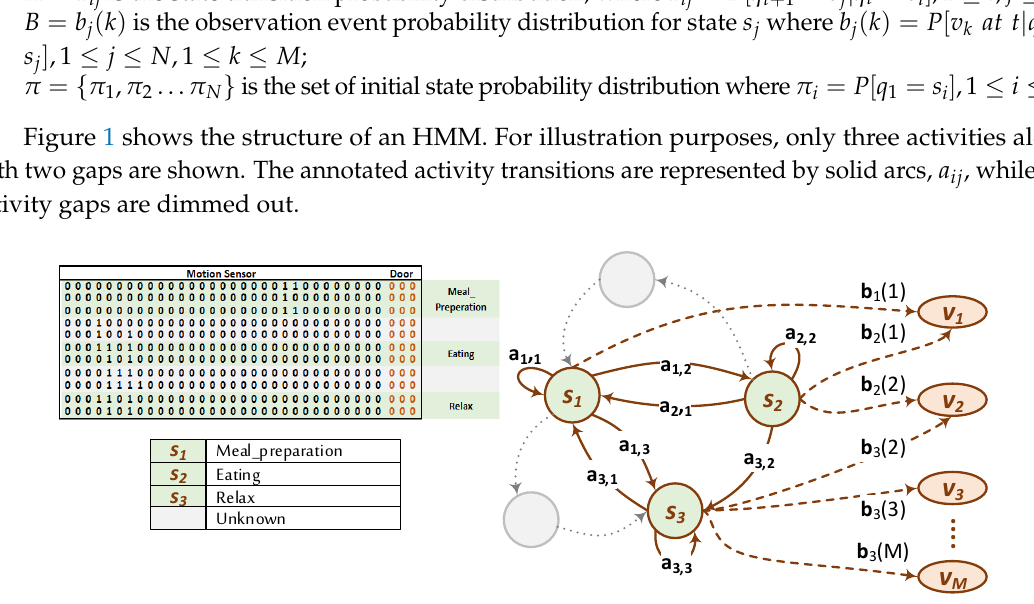
Figure 1. Graphical representation of the used HMM for activity recognition. Annotated events are represented by solid-circle states. Annotation gaps are shown in dimmed